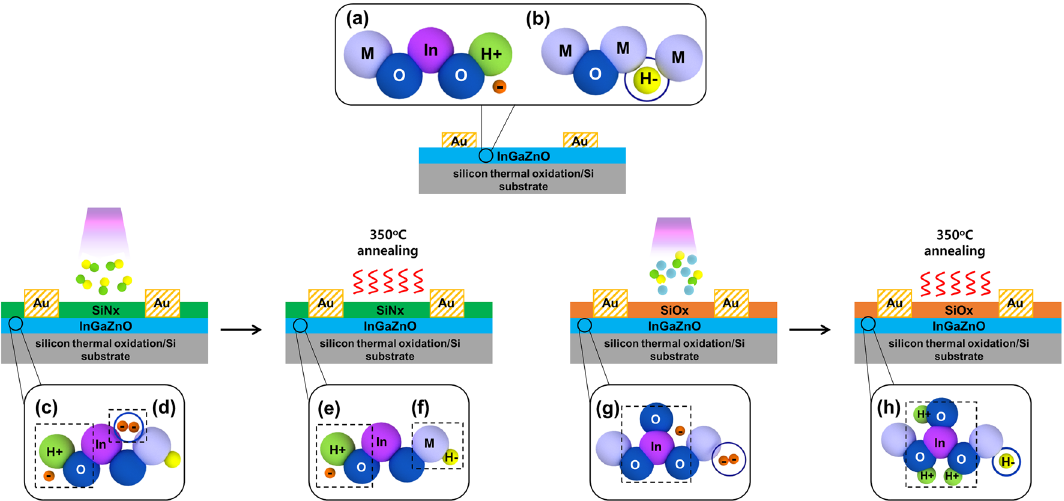
Figure 5. Schematics of ( a ) shallow donor generation in conventional a -IGZO film, ( b ) passivation of defects by hydrogen in conventional a -IGZO film. Formation of hydrogen, oxygen, and indium-related states ( c )–( f ) in a -IGZO films covered with SiN x , and ( g )–( h ) in a -IGZO films covered with SiO x